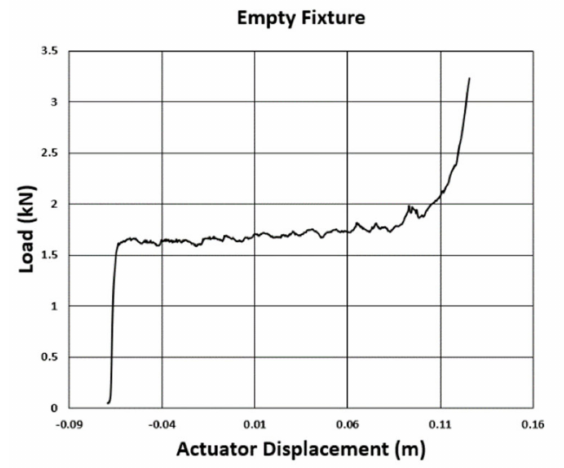
Figure 14. Empty fixture load vs. actuator